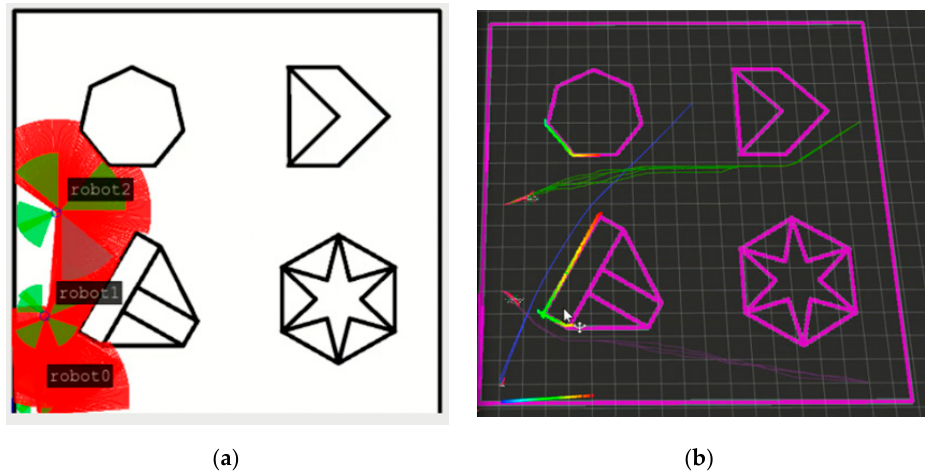
Figure 5. ( a ) The initial poses of the three mobile robots; ( b ) global path planning trajectories. Appl. Sci. 2019 , 9 , x FOR PEER REVIEW